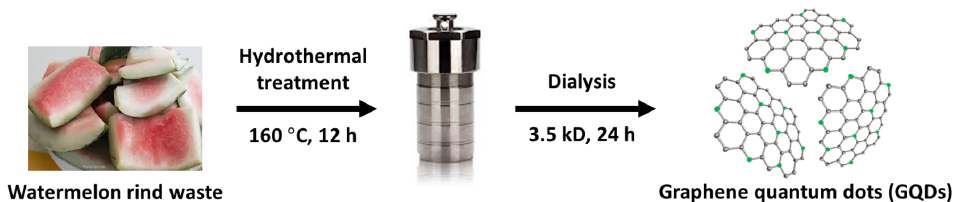
Figure 1. Preparation of GQDs from watermelon rind waste through the hydrothermal